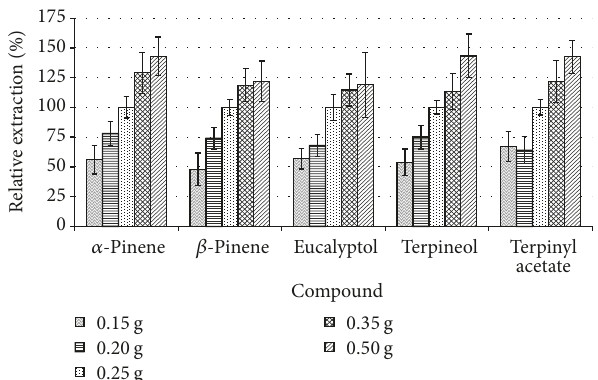
Figure 2: The effect of varying the amount of sample on the production of the